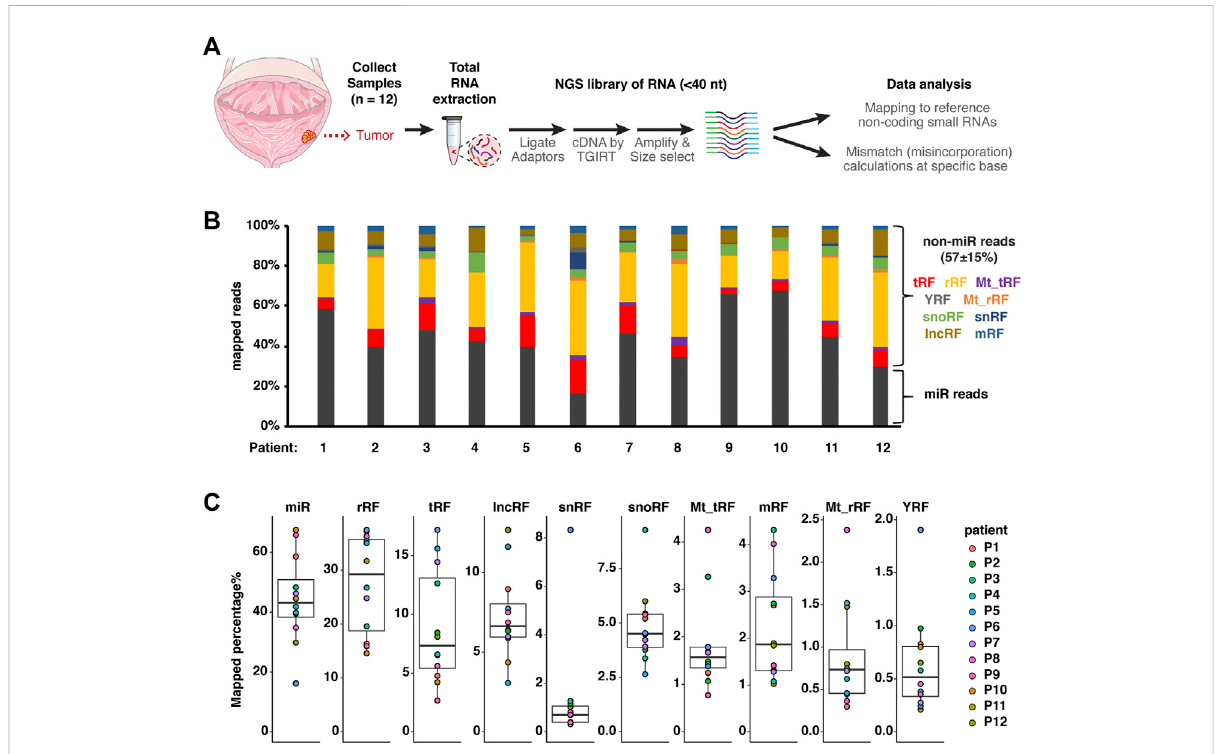
FIGURE 1 AnupdatedsmallRNA-seqwork fl owformodi fi cation-friendlyglobalanalysis. (A) Schemeofcollectingtumorsamplesfrom12NMIBCpatients. Small RNA-sequencing libraries by TGIRT were prepared from total RNAs to pro fi le relative abundance and potential RNA modi fi cations (based on mismatch/misincorporation) for small RNAs less than 40 bases long. (B) Overall distribution of total mapped reads between microRNAs (dark grey) and non-microRNA small RNAs (nmsRNAs), including rRFs (yellow), tRFs (red) and more. (C) Distribution of mapped percentage for each sub- group of small RNAs shown as box-whisker plot. Box plot center represents median value, bounds represent upper and lower quartile, whiskers represent 1.5* interquartile range from the